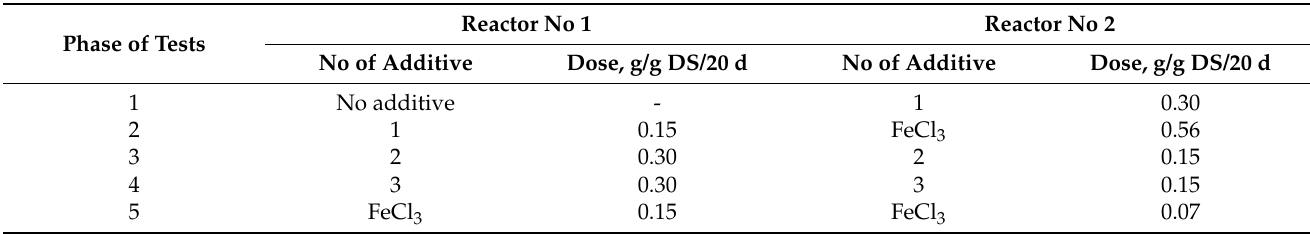
Table 2. The operation details and the design of tests.